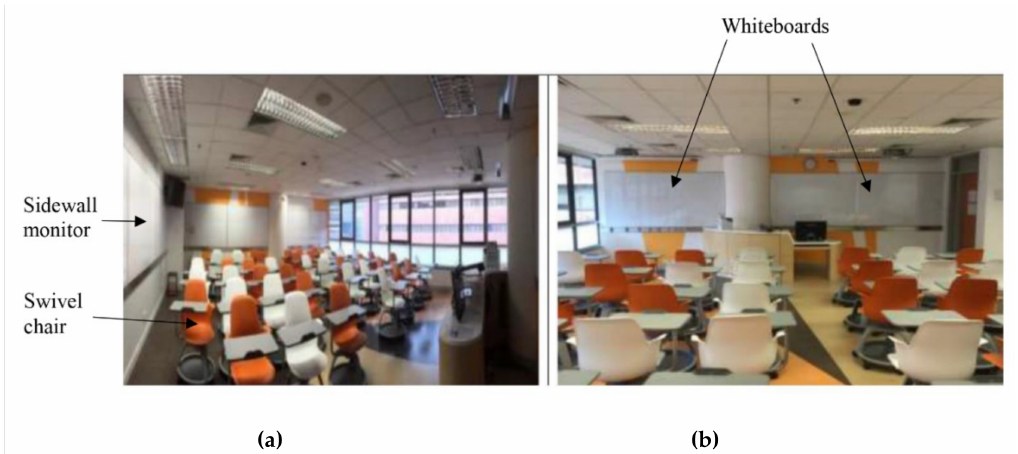
Figure 1. Upgrading of classroom (QR-611): Original tables and chairs ( b ) replaced by swivel chairs ( a ) to enhance personal comfort and facilitate student grouping.